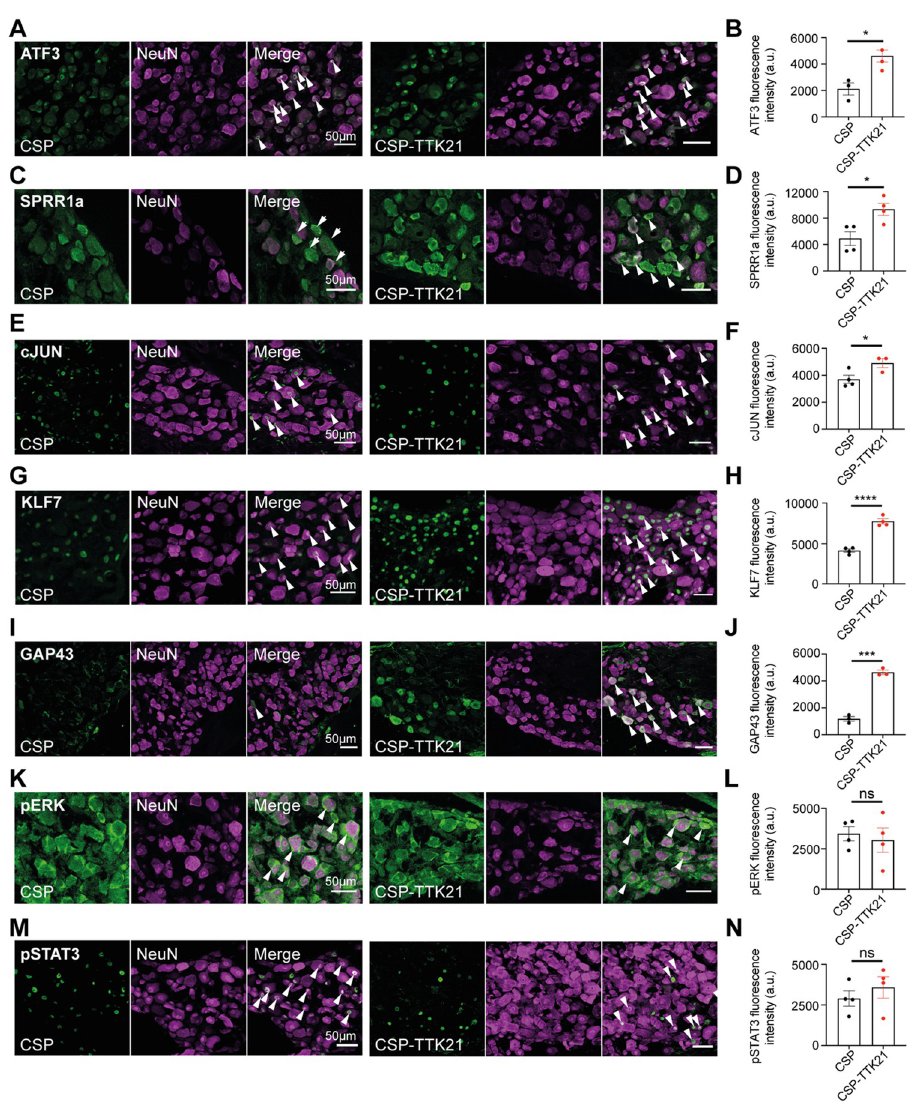
Fig 2. Expression of regeneration-associated proteins in DRG neurons in CSP-TTK21-treated mice in a chronic SCI. (A-N) Representative micrographs of immunostaining for regeneration-associated proteins (green, white arrows) in DRG neurons from CSP or CSP-TTK21-treated mice (A, C, E, G, I, K, M) and respective quantification of immunostaining in DRG neurons (B, D, F, H, J, L, N). ( A, B) Atf3 (CSP: 2,113.0 ± 461.5; CSP-TK21: 4,614.0 ± 449.4, p < 0.05). ( C, D) Sprr1a (CSP: 4,904.0 ± 1,033.0; CSP-TK21: 9,331.0 ± 914.6, p < 0.05). (E, F) cJun (CSP: 3,697.0 ± 302.2; CSP-TK21: 4,904.0 ± 340.7, p < 0.05). (G, H) Klf7 (CSP: 4,097.0 ± 199.1; CSP-TK21: 772.00 ± 317.9, p < 0.0001). ( I, J) Gap43 (CSP: 1,178.0 ± 173.2; CSP-TK21: 4,643.0 ± 163.6, p < 0.001). ( K, L) pErk (CSP: 3,433.0 ± 428.9; CSP-TK21: 3,036.0 ± 750.7, p = 0.66, TOST: t(4.8) = 0.03, p = 0.51 given equivalence bounds of − 366.7 and 366.7 on a raw scale and alpha of 0.05). ( M, N) pStat3 (CSP: 2,894.0 ± 470.1; CSP-TK21: 3,579.0 ± 656.8, p = 0.43, TOST: t(5.4) = − 0.42, p = 0.66 given equivalence bounds of − 342.7 and 342.7 on a raw scale and alpha of 0.05). Mean ± SEM; unpaired two-tailed Student or Welch t test; � p < 0.05, ��� p < 0.001, ���� p < 0.0001. n = 3 or 4 biologically independent animals. The data can be found in S1 Data. CSP, carbon nanosphere; DRG, dorsal root ganglion; SCI, spinal cord injury; TOST, two one-sided